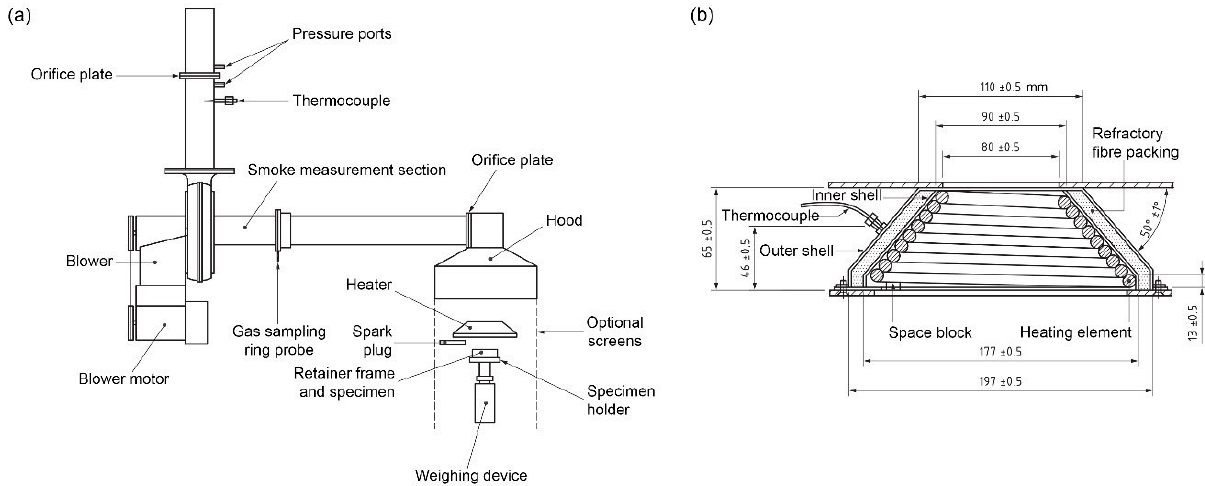
Figure 3. Test apparatus according to KS F ISO 5660-1 ( a ) Apparatus ( b ) Cone heater.